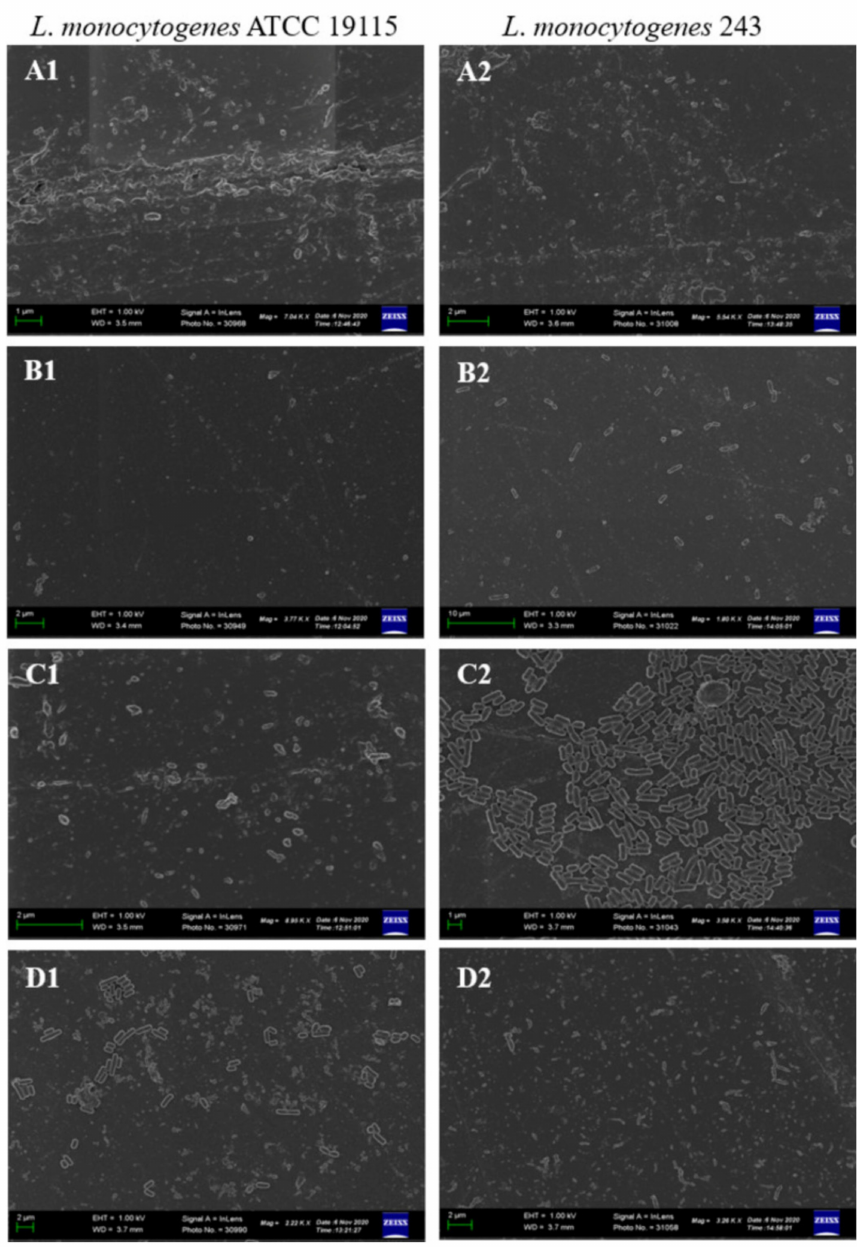
Figure 5. Scanning electron microscopy images of L. monocytogenes ATCC 19115 and L. monocytogenes 243 biofilms on PVC coupons after 7 days of incubation in TSB at 25 ◦ C ( A ), control; and after 1 h treatment with CFS of ( B ), L. acidophilus La14 150B; ( C ), L. plantarum B411; ( D ), L. rhamnosus ATCC